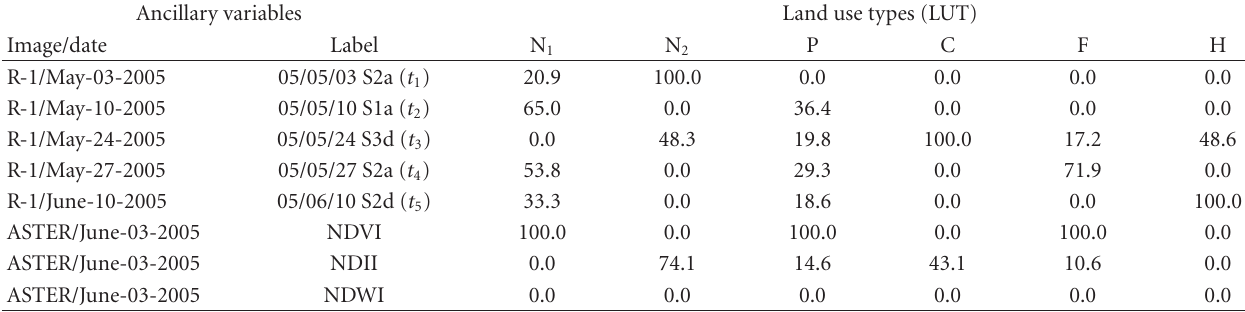
Table 7: Importance scores (IS) of various ancillary variables for di ff erent land use types